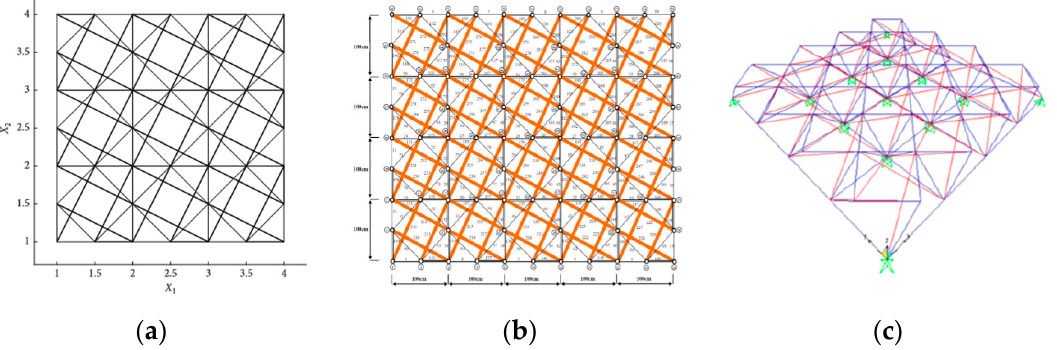
Figure 2. Double-layered tensegrity grids built with modified Quartex: ( a ) model of Wang and Xu [22], ( b ) model of Faroughi and Lee [23], ( c ) model of the Sulaiman et al. [24].